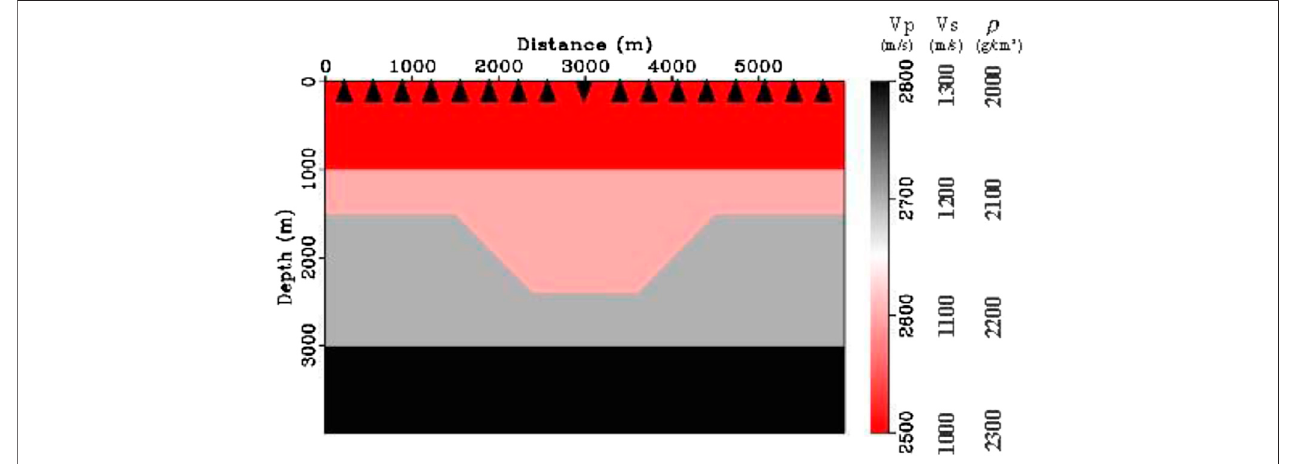
FIGURE 2 | The P-wave velocity, S-wave velocity, and density of a fault model. The model contains 600 points of dx (cid:1) 10 m in the x -axis and 400 points of dz (cid:1) 10 m inthe z -axis.TheinvertedtrianglemarksthelocationoftheexplosivesourcewithaRickerwaveletof30 Hz,andtrianglerepresentsreceiverswith20 minterval.